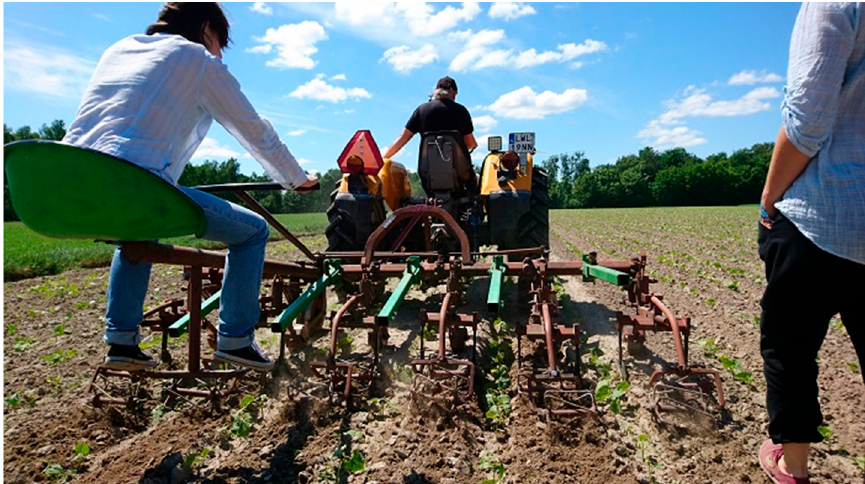
Figure 3. Practical classes at the Ecological Folk High School in Grzybów (image source: EFHSiG; http://www.eul.grzybow.pl/aktualnosci/134-zjazd-na-lubelszczyznie, accessed on 13 November